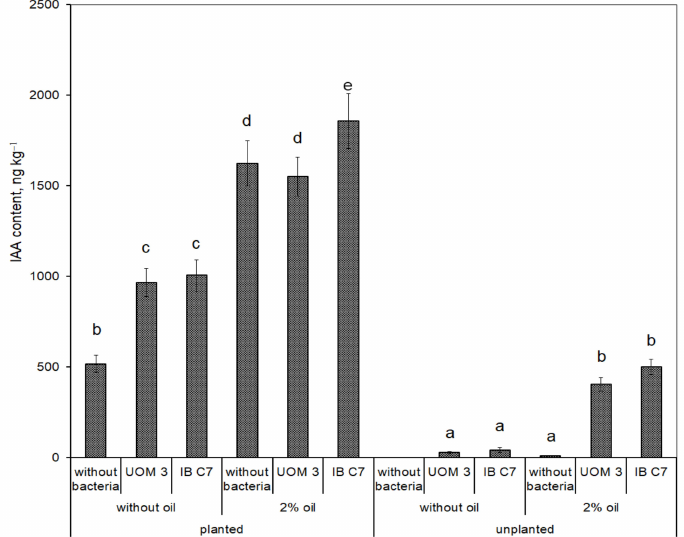
Figure 4. Indole-3-acetic acid content in pots planted and unplanted with barley, ng kg − 1 of sand. UOM 3 and IB C7—treatments with introduction of Enterobacter sp. UOM 3 and P. hunanensis IB C7, respectively. Statistically different means (n = 9) are marked with different letters ( p ≤